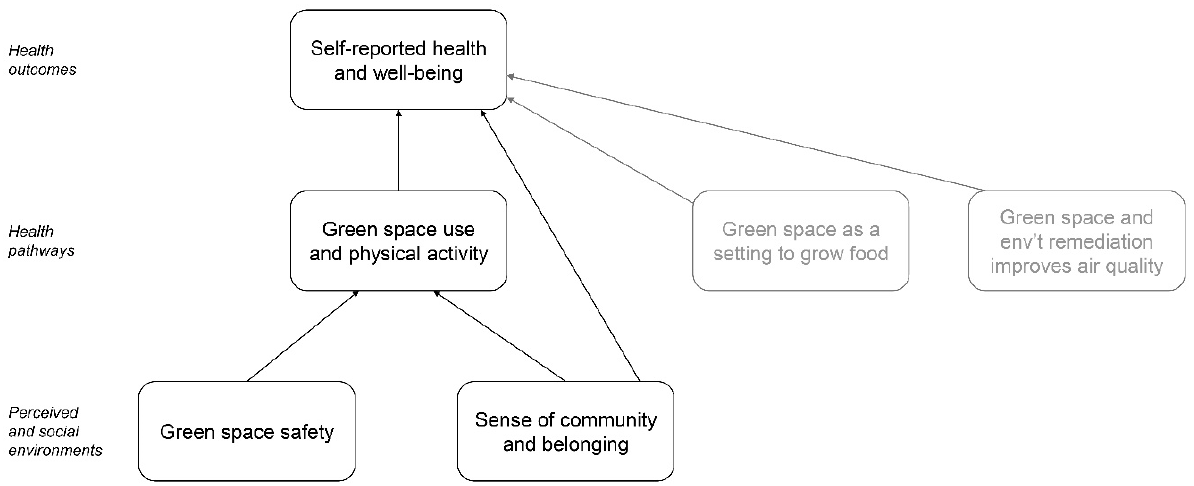
Figure 2. Literature map based on the 15 studies identified in this review. Text in gray represents content included in fewer studies.